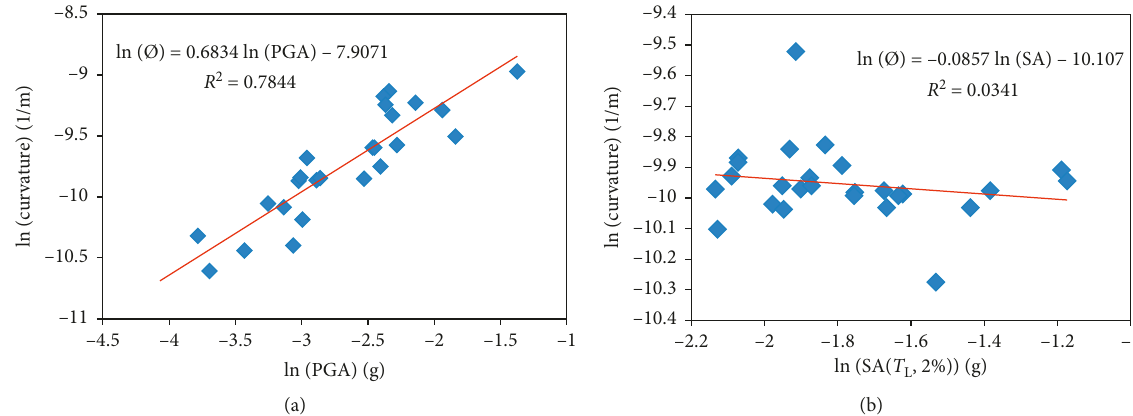
Figure 13: Probabilistic seismic demand models for the curvature of the slope section. (a) PSDM with PGA. (b) PSDM with